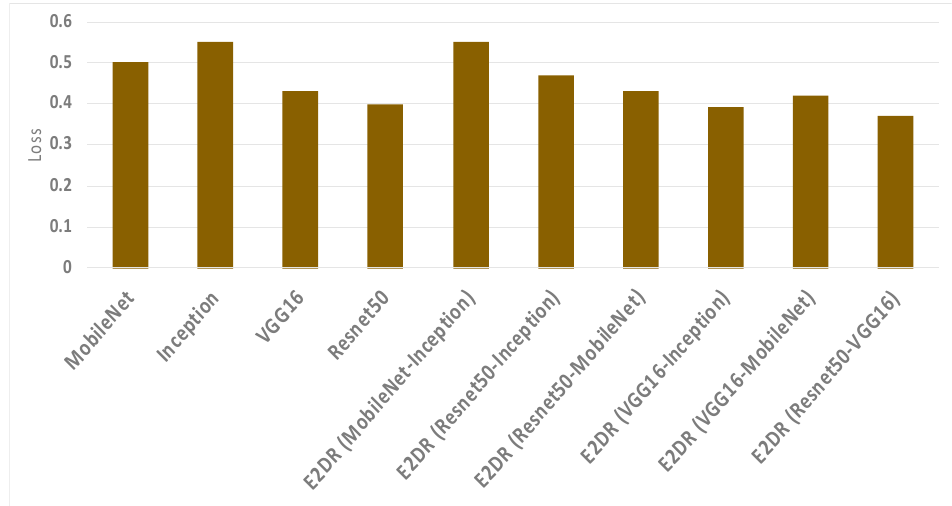
Figure 18. The Loss of base models and E2DR models.